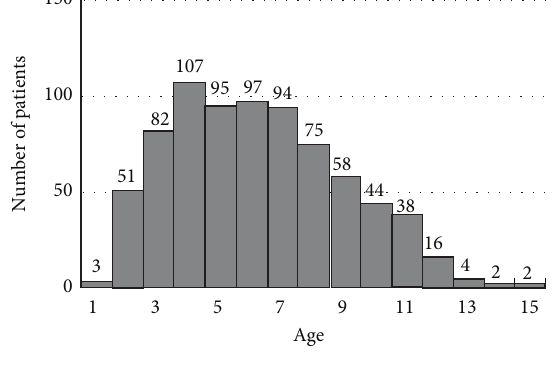
Figure 1: Distribution of patients.